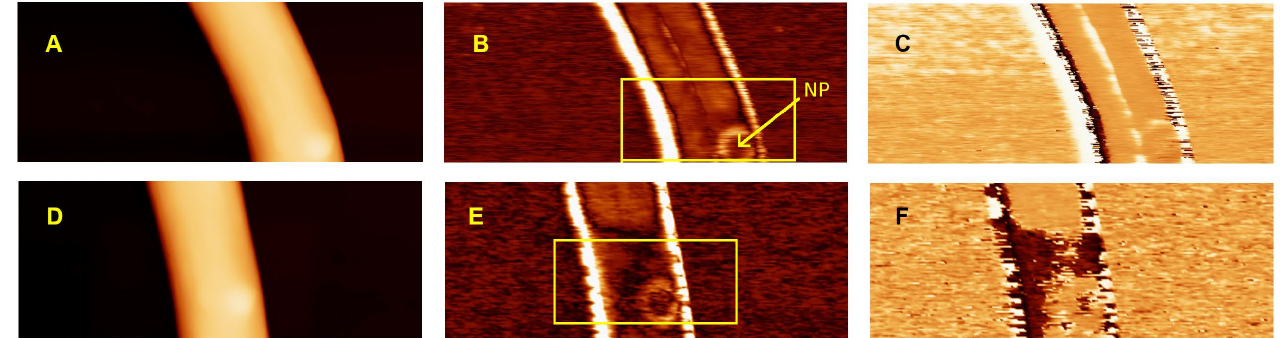
Figure 3. Topography ( A ), CE-FM-PFM amplitude ( B ) and phase ( C ) scan of an electrospun PVDF/BaTiO 3 composite nanofiber deposited on doped silicon, where an embedded BaTiO 3 nanoparticle is present (NP), indicated by the arrow. Nanodomains appear at the center of the fiber upper surface, where the PFM phase is inverted. The nanoparticle shows lower piezoresponse, while its border shows a higher signal. Topography ( D ), CE-FM-PFM amplitude ( E ) and phase ( F ) of the same nanofiber portion after poling by application of a DC potential to a region indicated by the rectangle in ( B , E ). Phase inversion is obtained after poling on the PVDF nanofiber, as well as on the nanoparticle and part of the nanodomains. The scan size is 1.28 µm × 0.5 µm. The same color bar of the image of Figure 2A defines the scale for the values of topography images ( A , D ) (0/250 nm), PFM amplitude ( B , E ) (0/50 pm/V) and phase ( C , F ) (−180°/+180°).